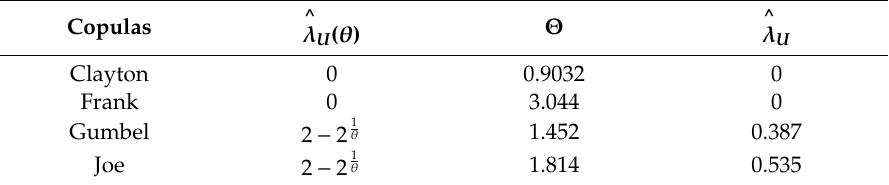
Table 6. Upper tail dependence coefficient of used the copula.